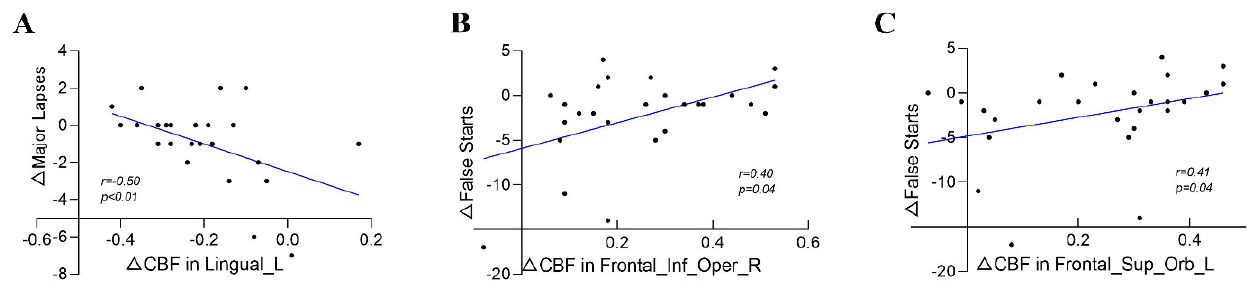
Figure 5. ( A ) Correlation between Lingual_L and major lapses; ( B ) Correlation between Frontal_Inf_Oper_R and false starts; ( C ) Correlation between Frontal_Sup_Orb_L and false starts. Table 3. Correlation between PVT changes and CBF changes.